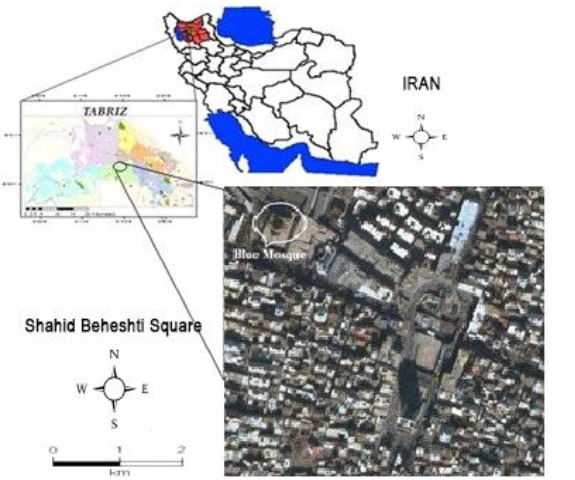
Fig. 1: Shahid Beheshti Square location in Tabriz